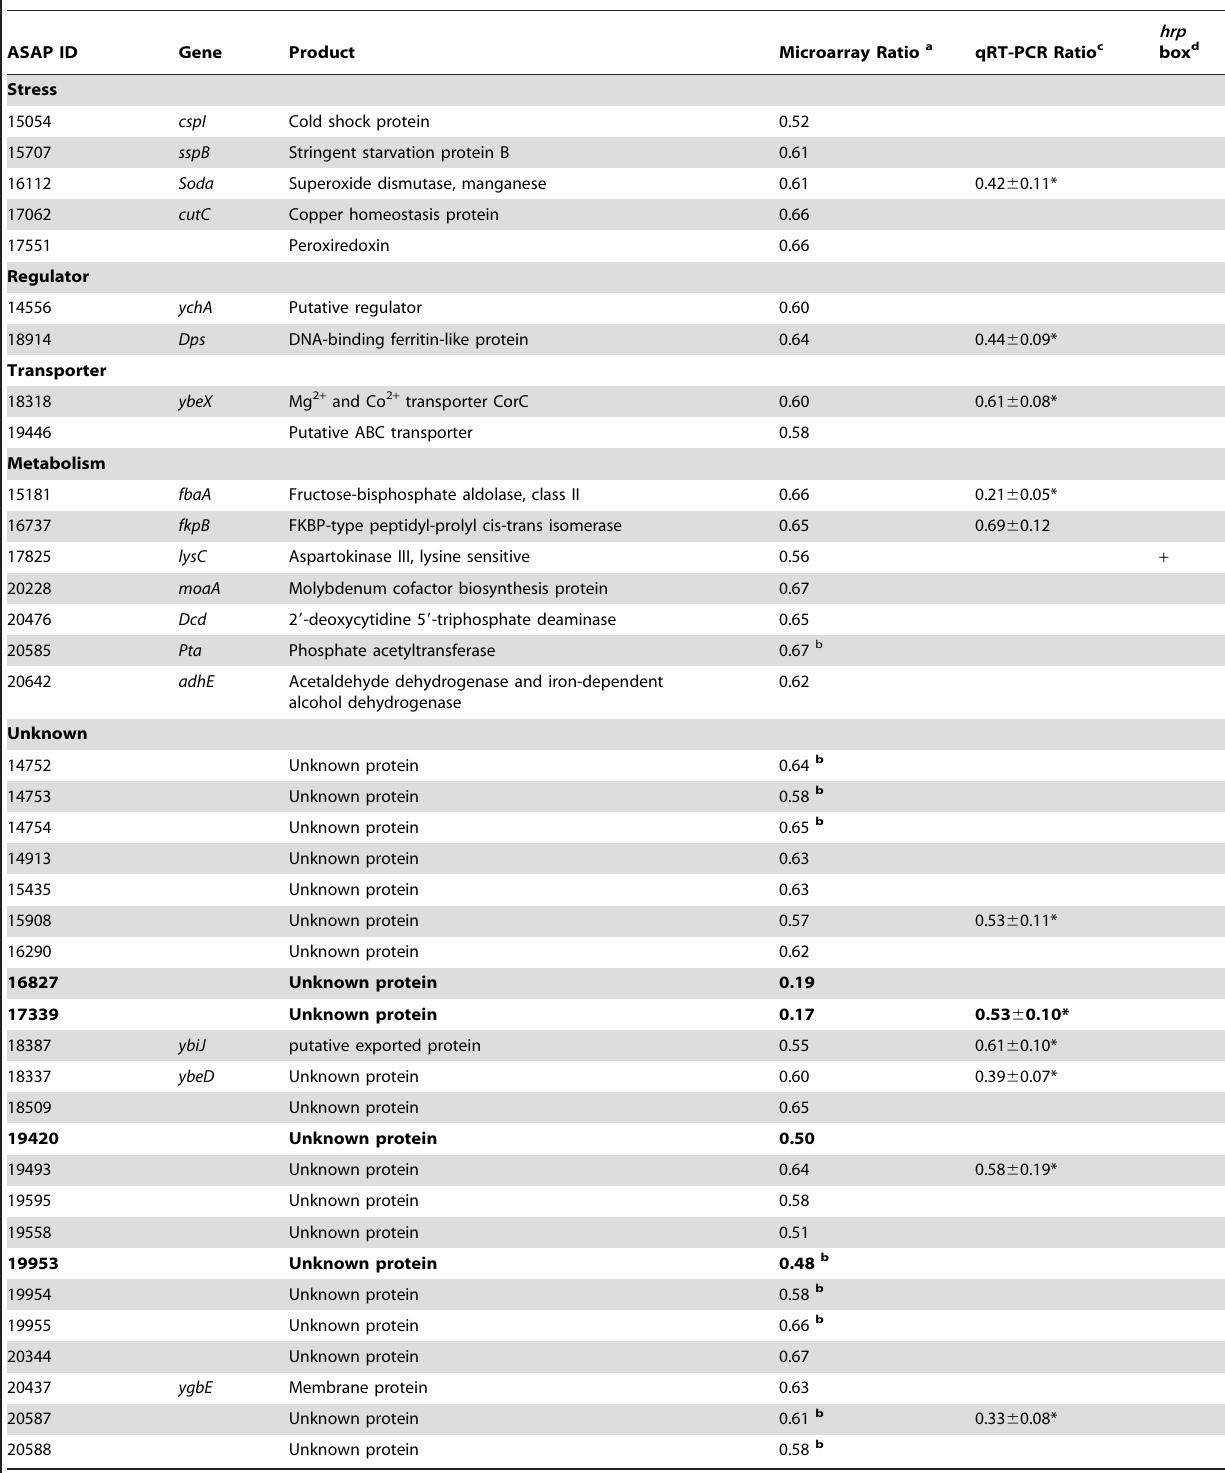
Table 2. HrpL down-regulated genes in Dickeya dadantii